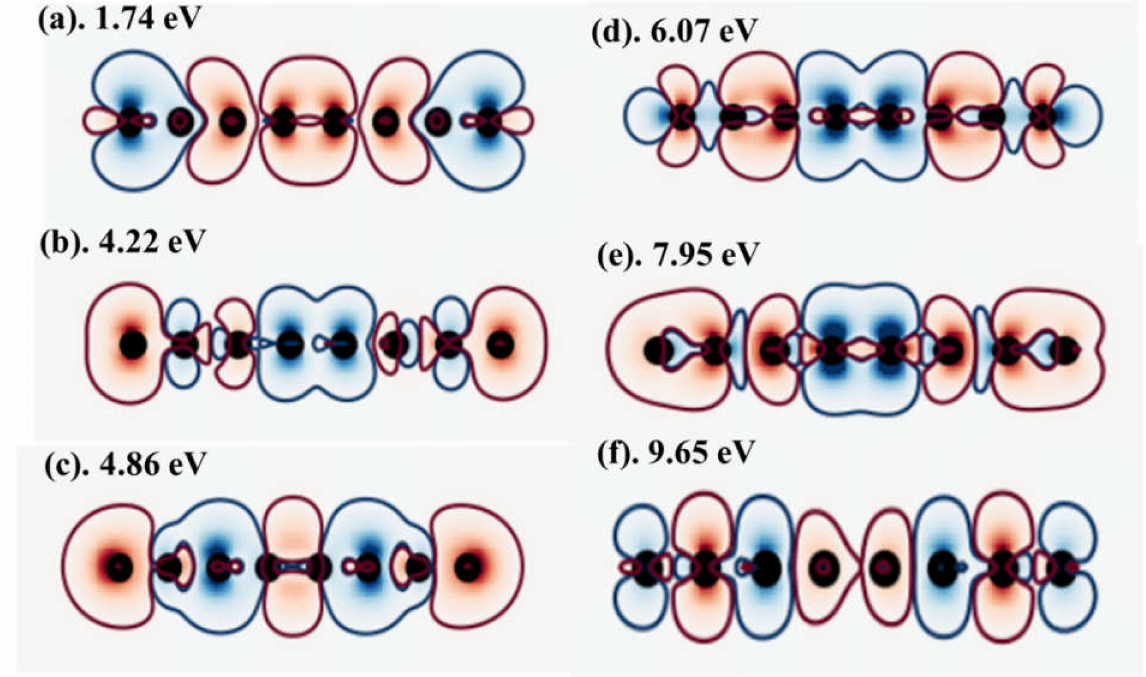
Figure 8. Field-induced carrier density wave along the carbon nanoline at a photon energy of 1.74 ( a ). 4.22 ( b ). 4.86 ( c ). 6.07 ( d ). 7.95 ( e ). 9.65 eV ( f ). Black balls denote atomic cores, while blue and red colors indicate minimal and maximal carrier density (in Coulombs/Å3),